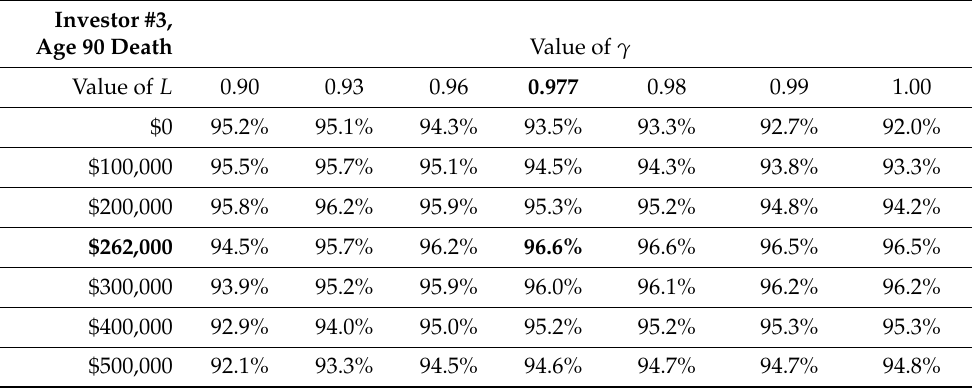
Table 10. The effect of varying the values of L and γ from their optimal (in bold) values on the solvency probability for Investor #3 if the investor’s date of death is projected to be at age